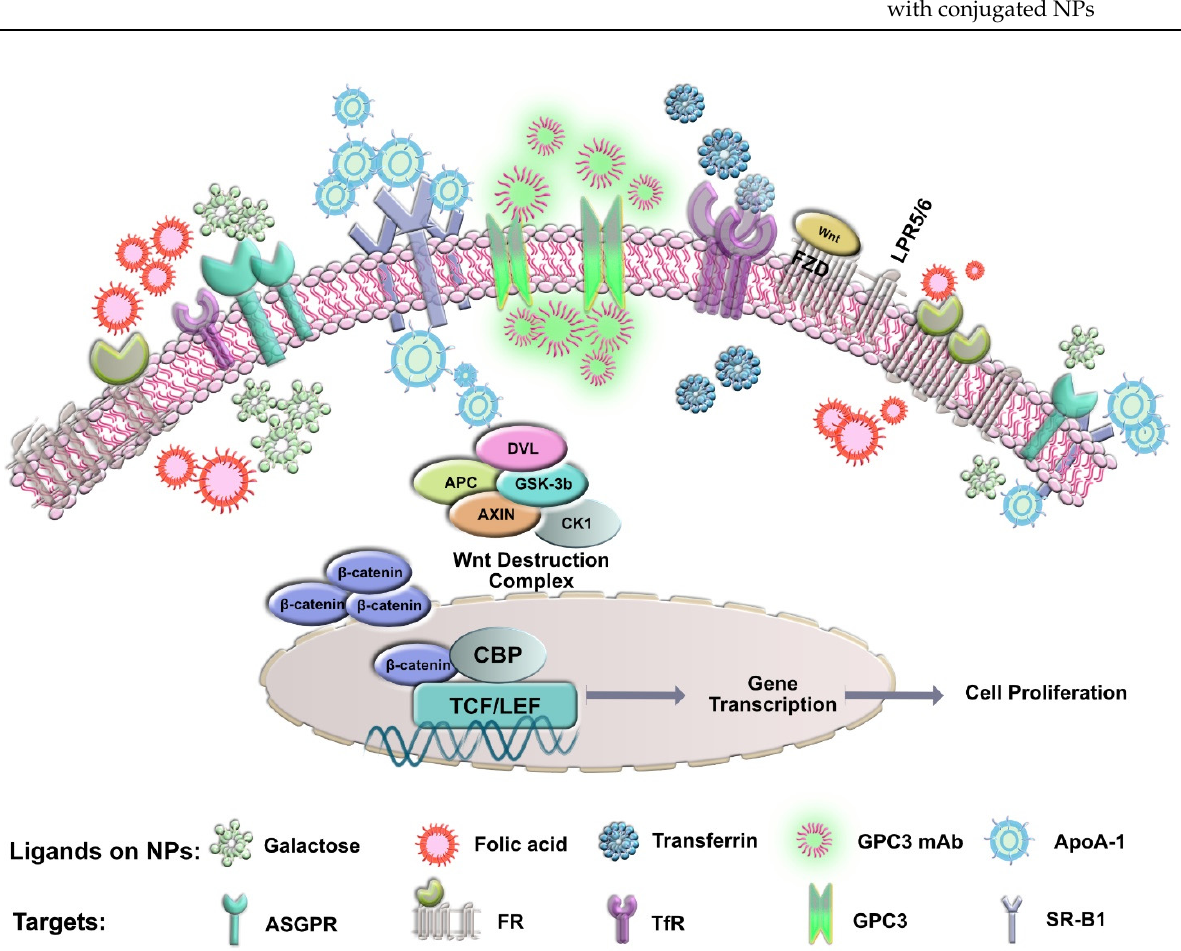
Figure 1. Illustration showing specific targets and ligands for HCC nanomedicine. Table 2. Summary of the various GPC3-targeting antibodies currently under research.